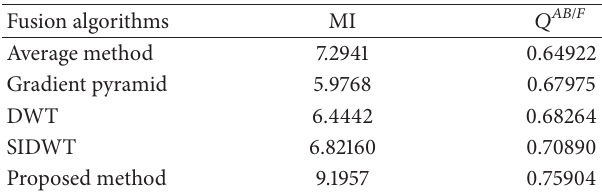
Table 2: Performance comparison of different fusion algorithms in Figure 5.